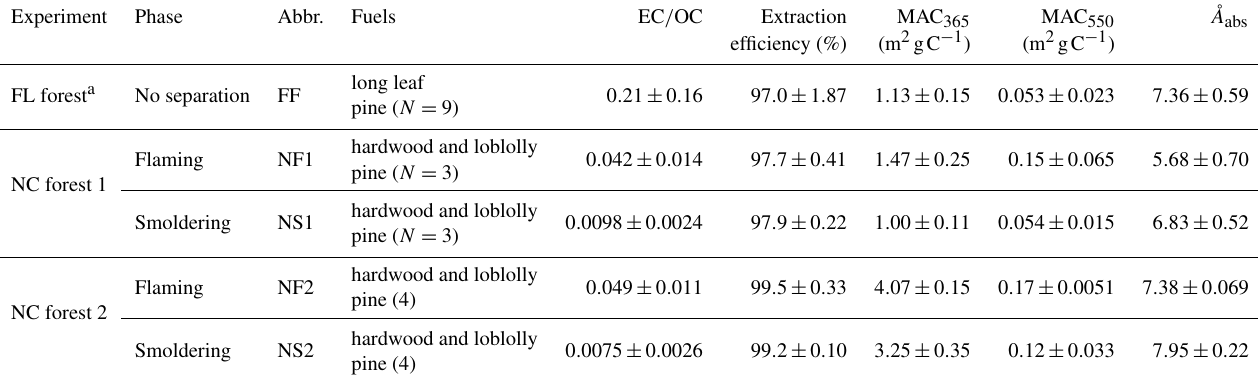
Table 1. EC / OC ratio, OC extraction efficiency, and light-absorbing properties of organic aerosols in PM 2 . 5 from laboratory biomass burning. Experiment Phase Abbr. Fuels EC / OC Extraction MAC 365 MAC 550 Å abs efficiency (%) (m 2 gC − 1 ) (m 2 gC − 1 ) long leaf FL forest a No separation FF 0 . 21 ± 0 . 16 97 . 0 ± 1 . 87 1 . 13 ± 0 . 15 hardwood and loblolly Flaming NF1 0 . 042 ± 0 . 014 NC forest 1 hardwood and loblolly NS1 hardwood and Flaming NF2